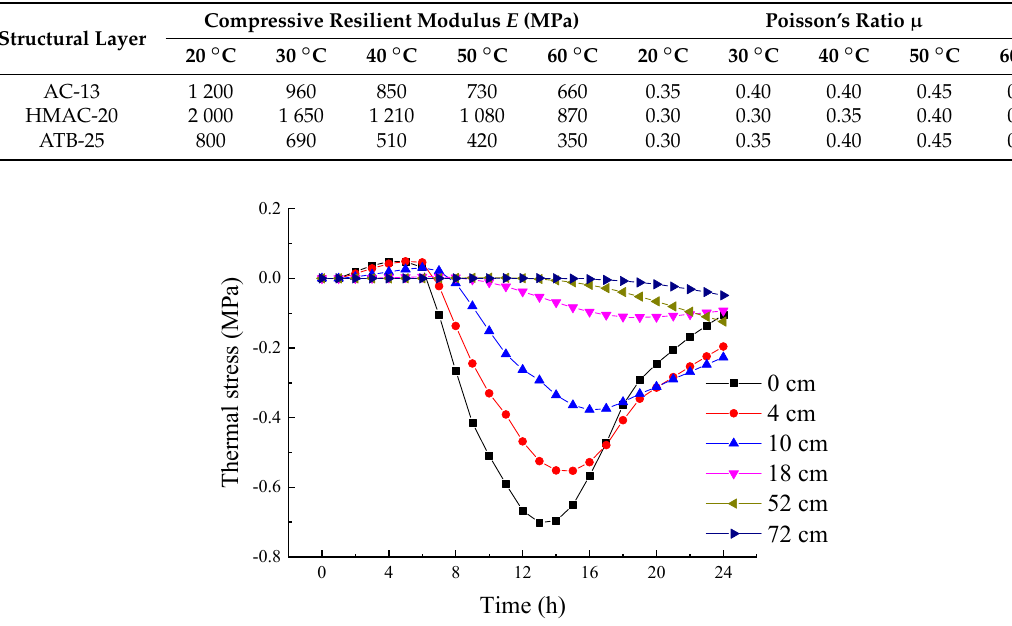
Figure 9. Thermal stress of each structural layer over 24 h.